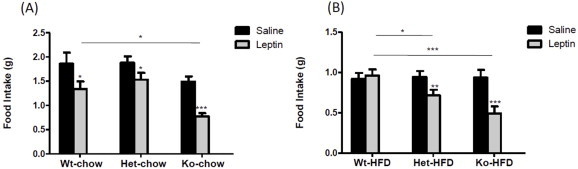
Glucose tolerance is improved in Fto deficient mice compared to Fto+/+ mice following 5 weeks of 60% HFD. (A) Oral glucose tolerance test (OGTT) was performed in mice fasted for six hours and blood samples were obtained for glucose measurement at indicated time points for Fto+/+ (n = 10, blue); Fto+/− (n = 11, red) and Fto−/− (n = 10, green). **p < 0.01 (Fto+/+ vs. Fto+/−), ###p < 0.001 (Fto+/+ vs. Fto−/−) analysed by repeated measures ANOVA followed by the Bonferroni multiple comparison test. (B) Area under the curve [26] for blood glucose during OGTT. *p < 0.05; **p < 0.01 following two-tailed t-test.